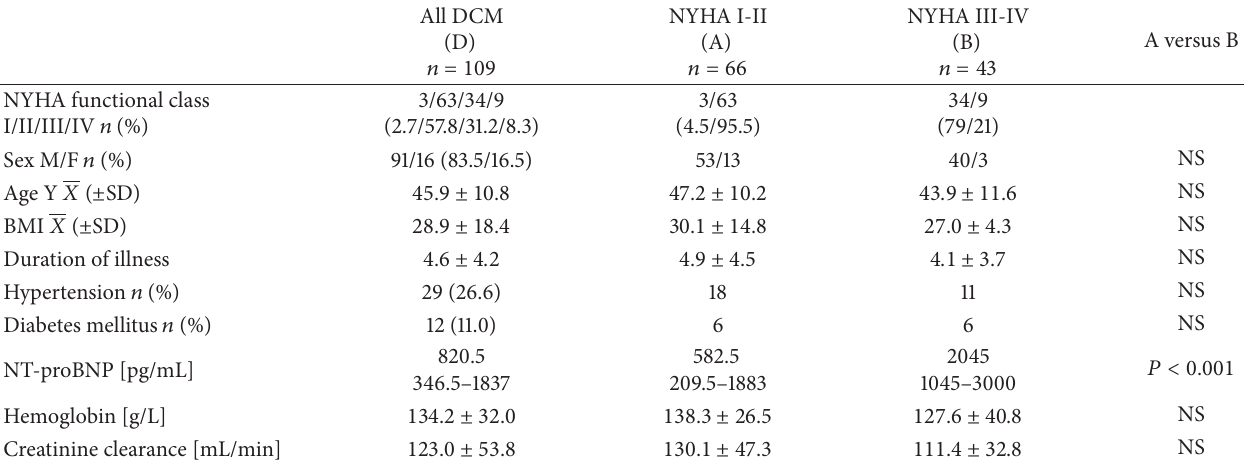
Table 2: Clinical and selected laboratory results in all patients and with division into groups depending on NYHA class.